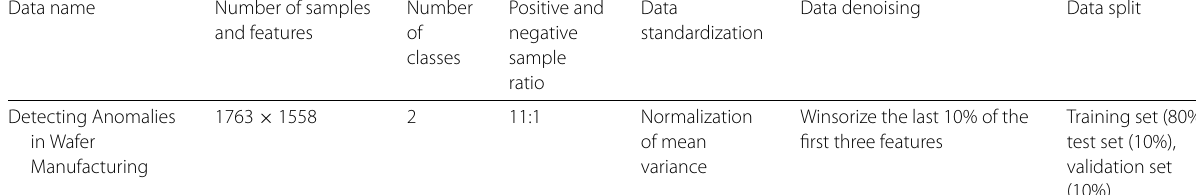
Table 2 Data description and preprocessing